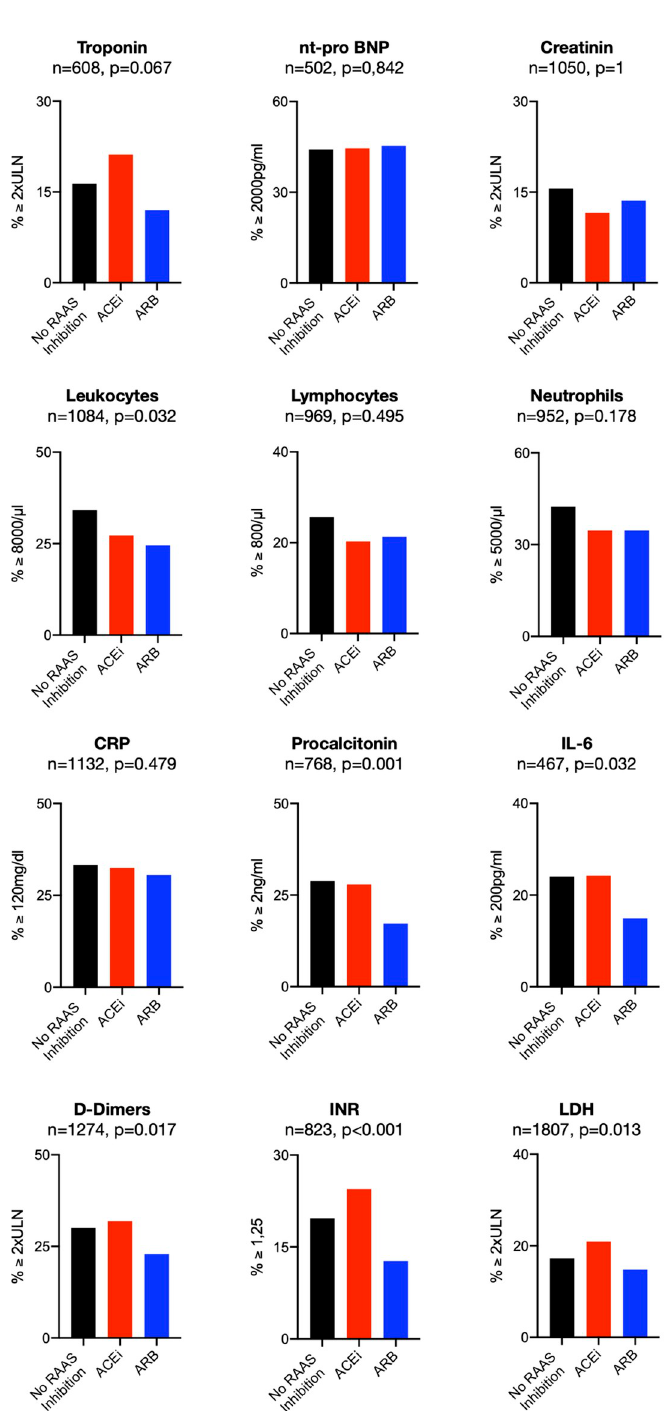
Fig 5. Biomarkers in uncomplicated patients with CVD/Hypertension. Percentage of patients above the mortality predicting threshold for biomarkers calculated by ROC analysis in patients in an uncomplicated stage of COVID-19 at baseline with cardiovascular disease for patients without RAAS-modulation, patients on ACEi and patients taking ARBs. n-numbers and p-values are depicted above each panel.